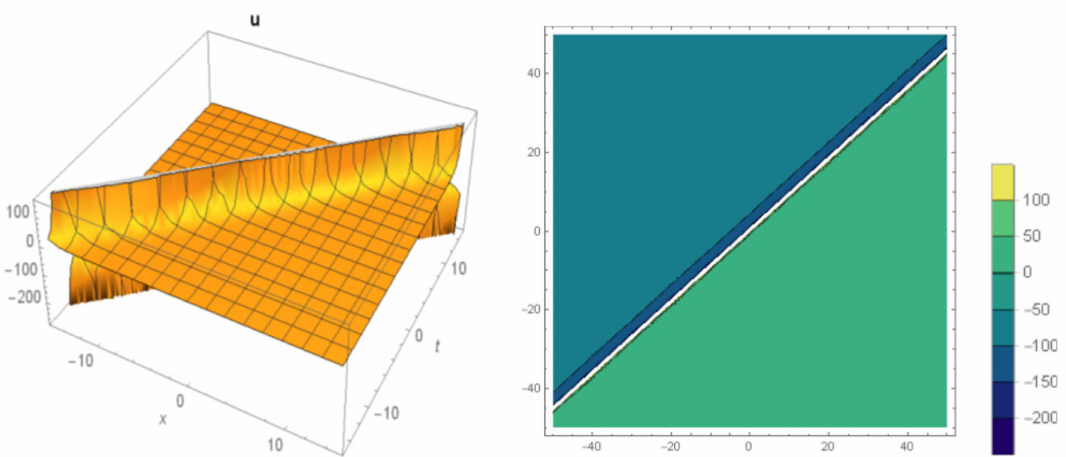
Figure 3. 3D and contour graphs of Equation (18) for α = 0.2, b = 0.3, c = − 0.5, ε = 0.4, d = 0.1, − 15 < x < 15, − 15 < t < 15.